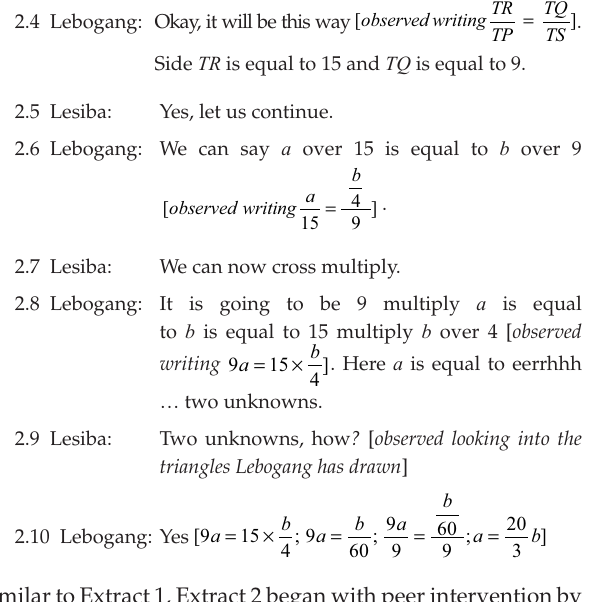
FIGURE 3: Proportionality in similar